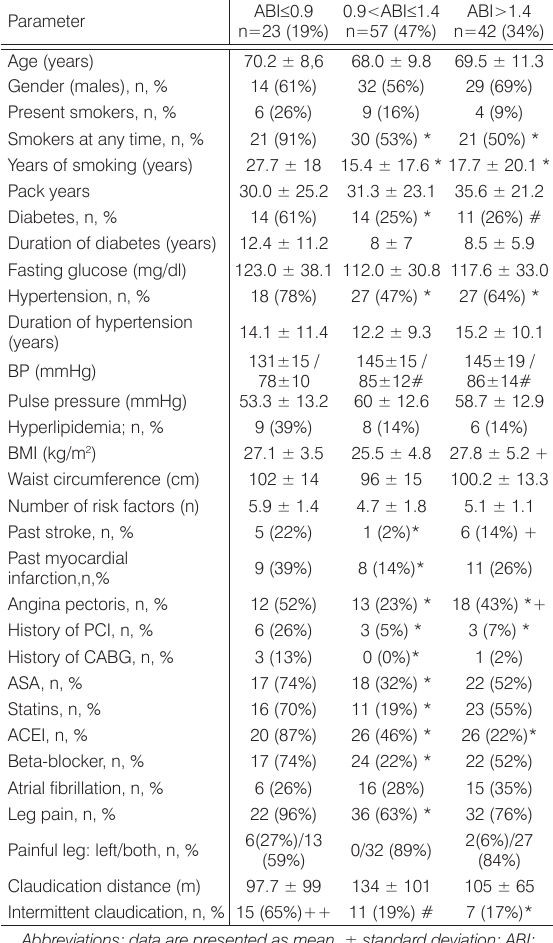
Table 1. Demographic and clinical characteristics of patients divided in relation to ABI range.